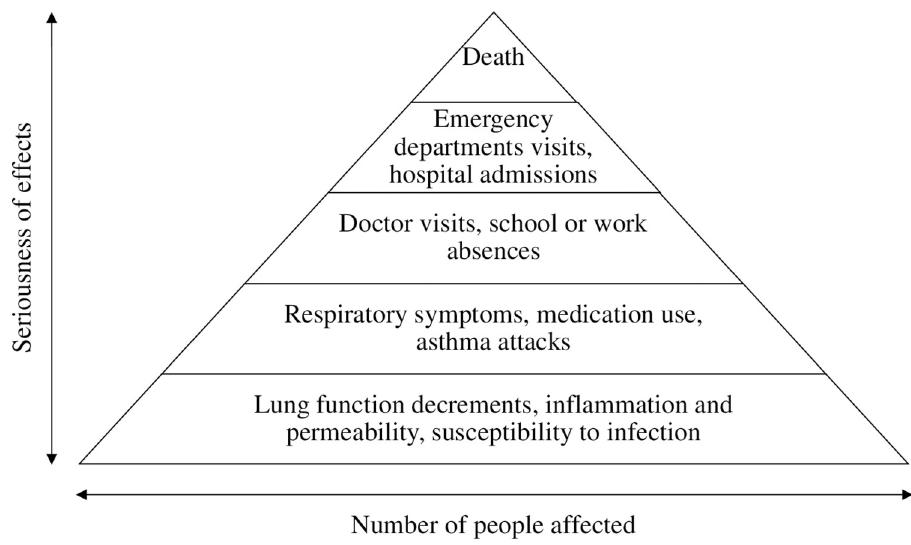
Fig 1. The effects of ozone on human health [1].